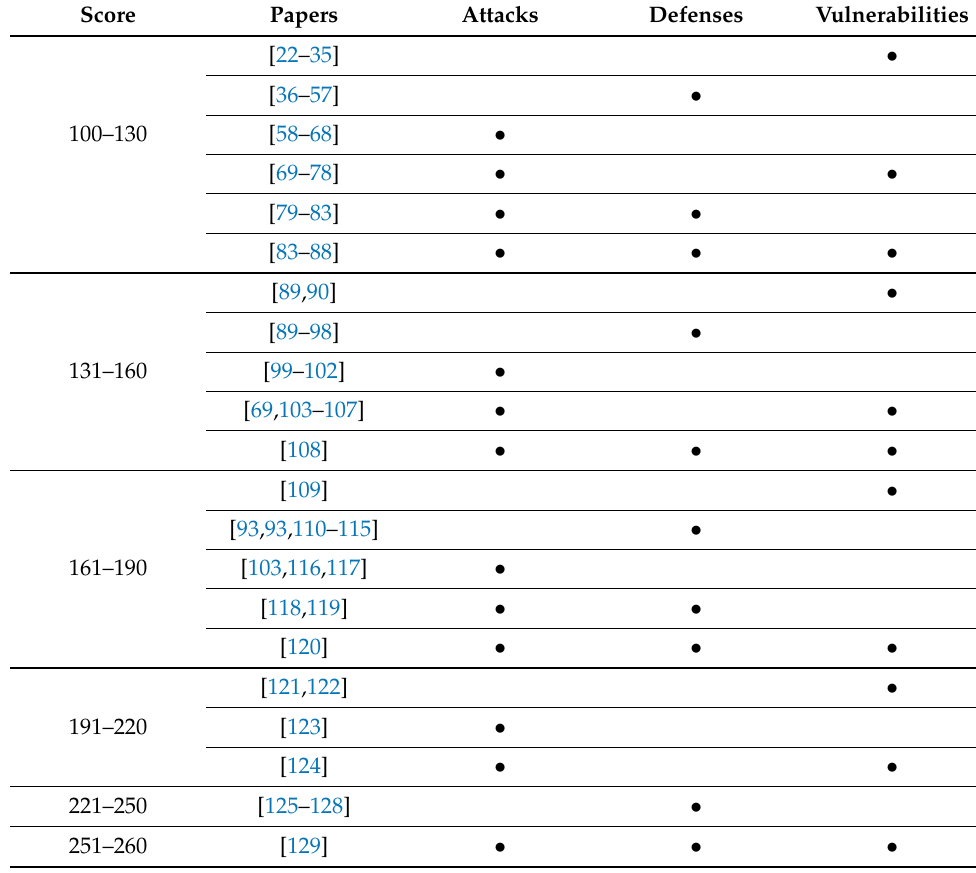
Table 3. Paper Score and Categorization for the Review of Abstracts.